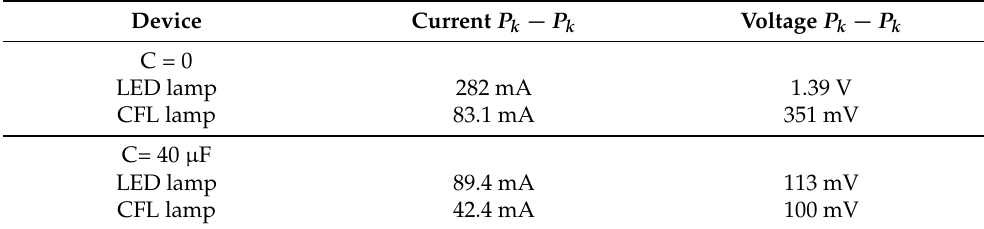
Figure 16. Attenuated voltage and current ripple in ( a ) LED lamp, and ( b ) CFL lamp due to the EMI filter at induction stove. Table 2. Experimental